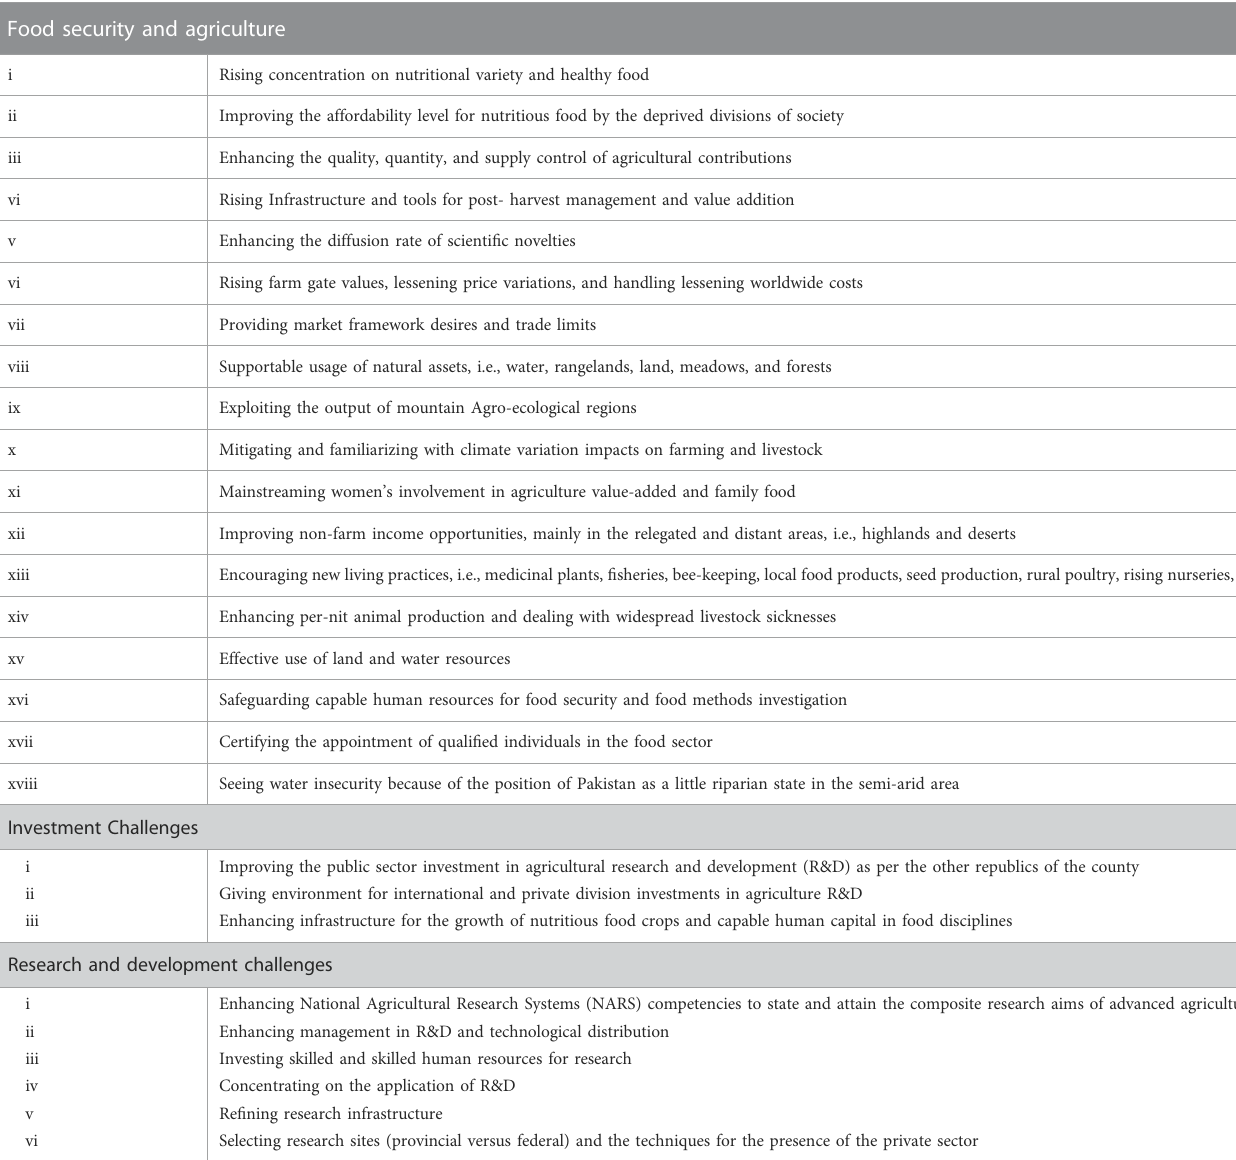
TABLE 1 Key challenges to Pakistan ’ s food security and agriculture (Ministry of National Food Security and Research, 2018) 2 . Food security and